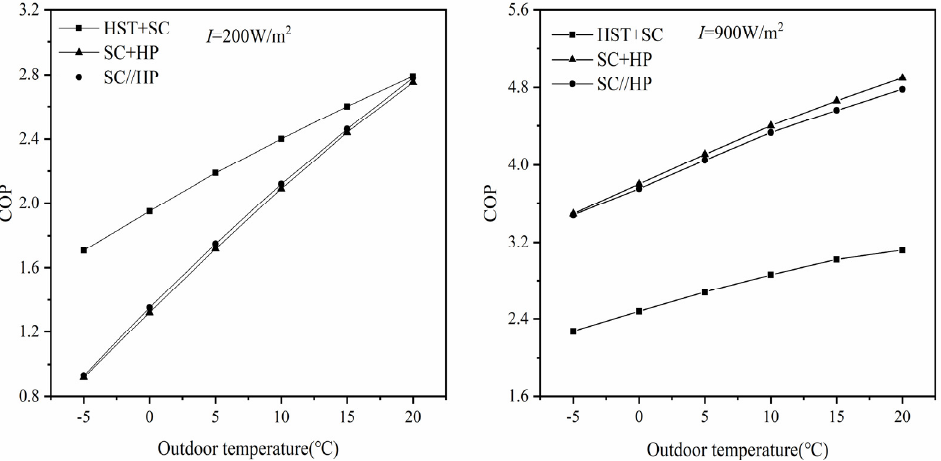
Figure 10. The COP change of three systems with outdoor temperature under different solar radiation intensities.